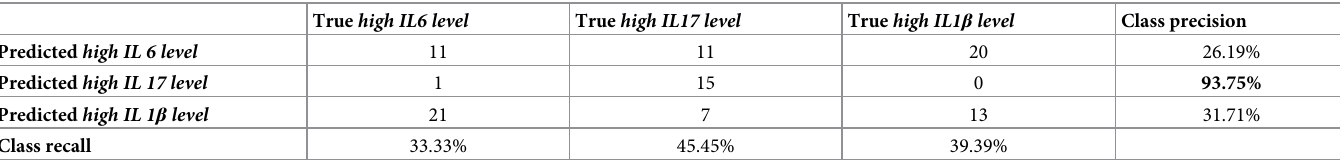
Table 2. Performance parameters of classification model targeting three labels high IL17 level vs. high IL1 β level vs. high IL6 level independently. Accuracy 39.33%.